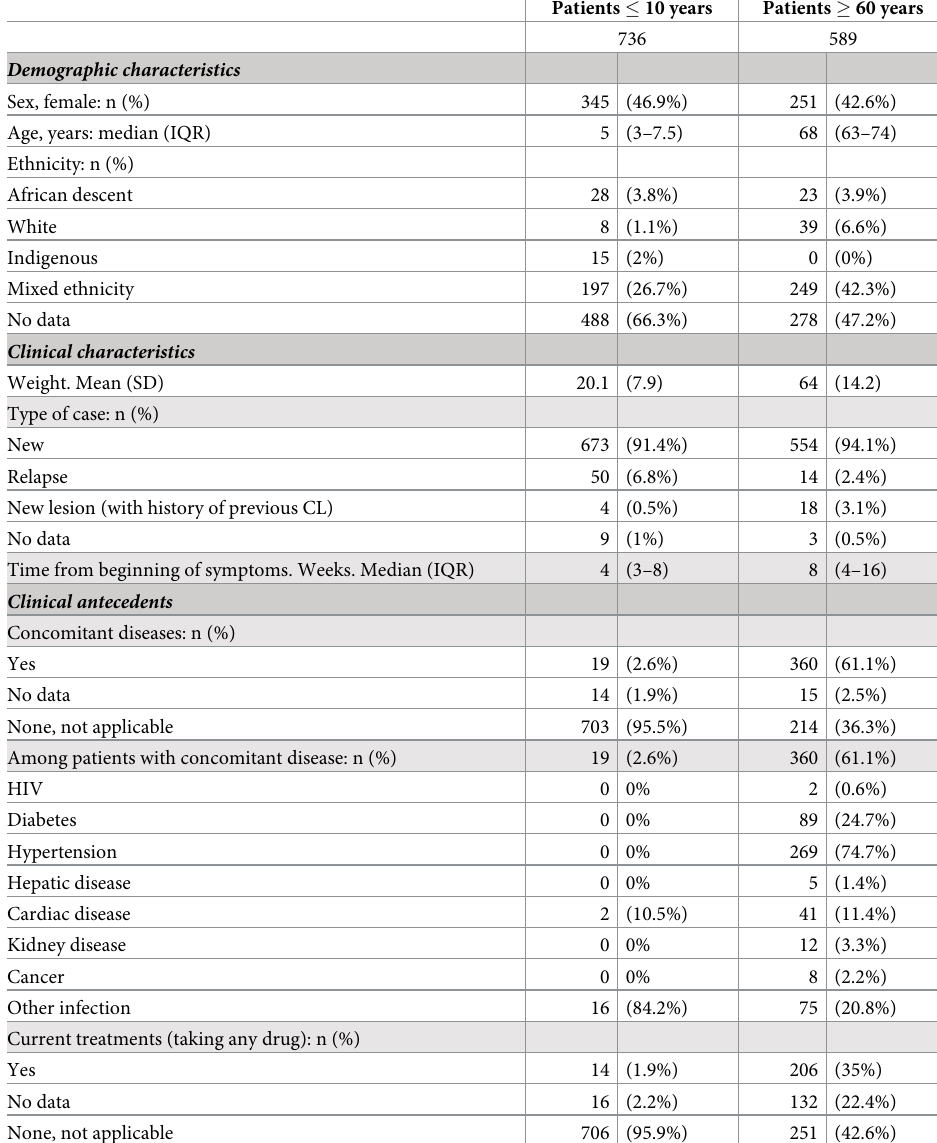
Table 1. Clinical and demographic characteristics of